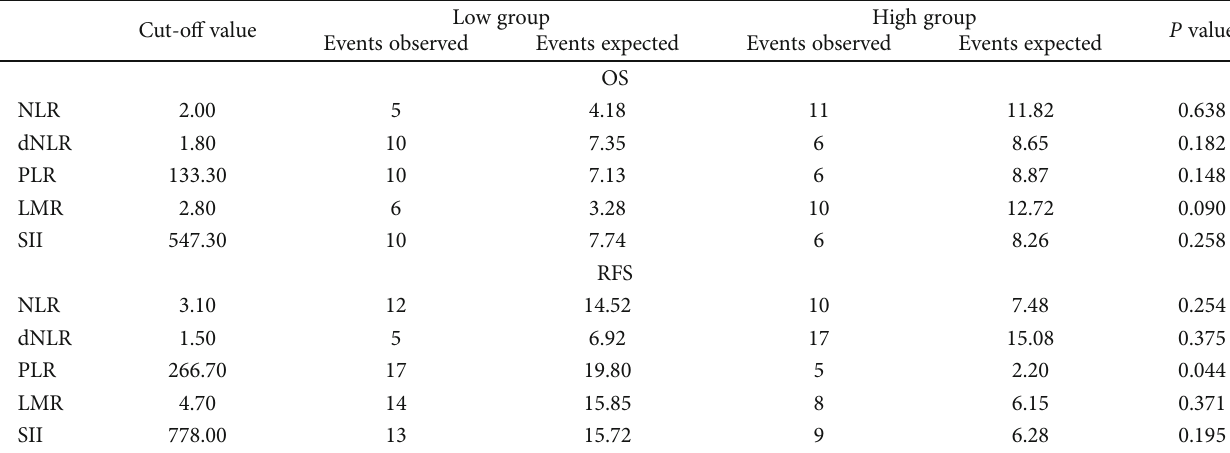
Table 4: The Kaplan-Meier results of OS and RFS grouped by the